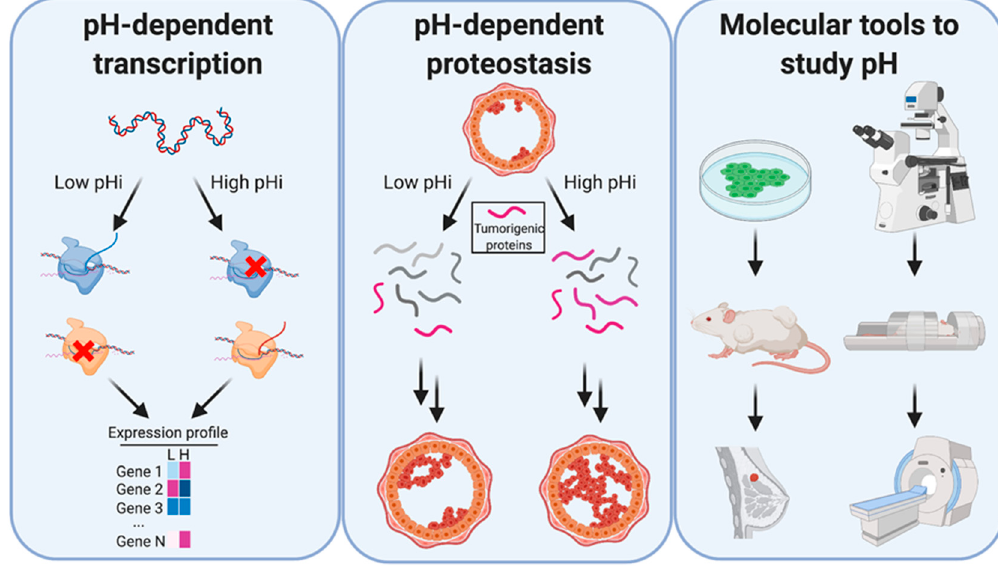
Figure 2. Dysregulated pHi dynamics in cancer can regulate transcription and proteostasis, but better tools are needed to study molecular effects. Left: Altered pH dynamics can affect transcript abundance, where gene 1 transcription is activated by high pHi, gene 2 transcription is activated by low pH, and gene 3 is unaffected. Middle: Altered pH dynamics can also play a role in stabilizing tumorigenic proteins, enabling cancer establishment or progression. Right: Currently, tools exist that allow researchers to study pHi dynamics in living cells by optical microscopy and magnetic resonance imaging (MRI). However, experiments are limited by the constraints of the individual tools, and better tools are required to study the role of pHi dynamics at the cellular, tissue, and organismal level.